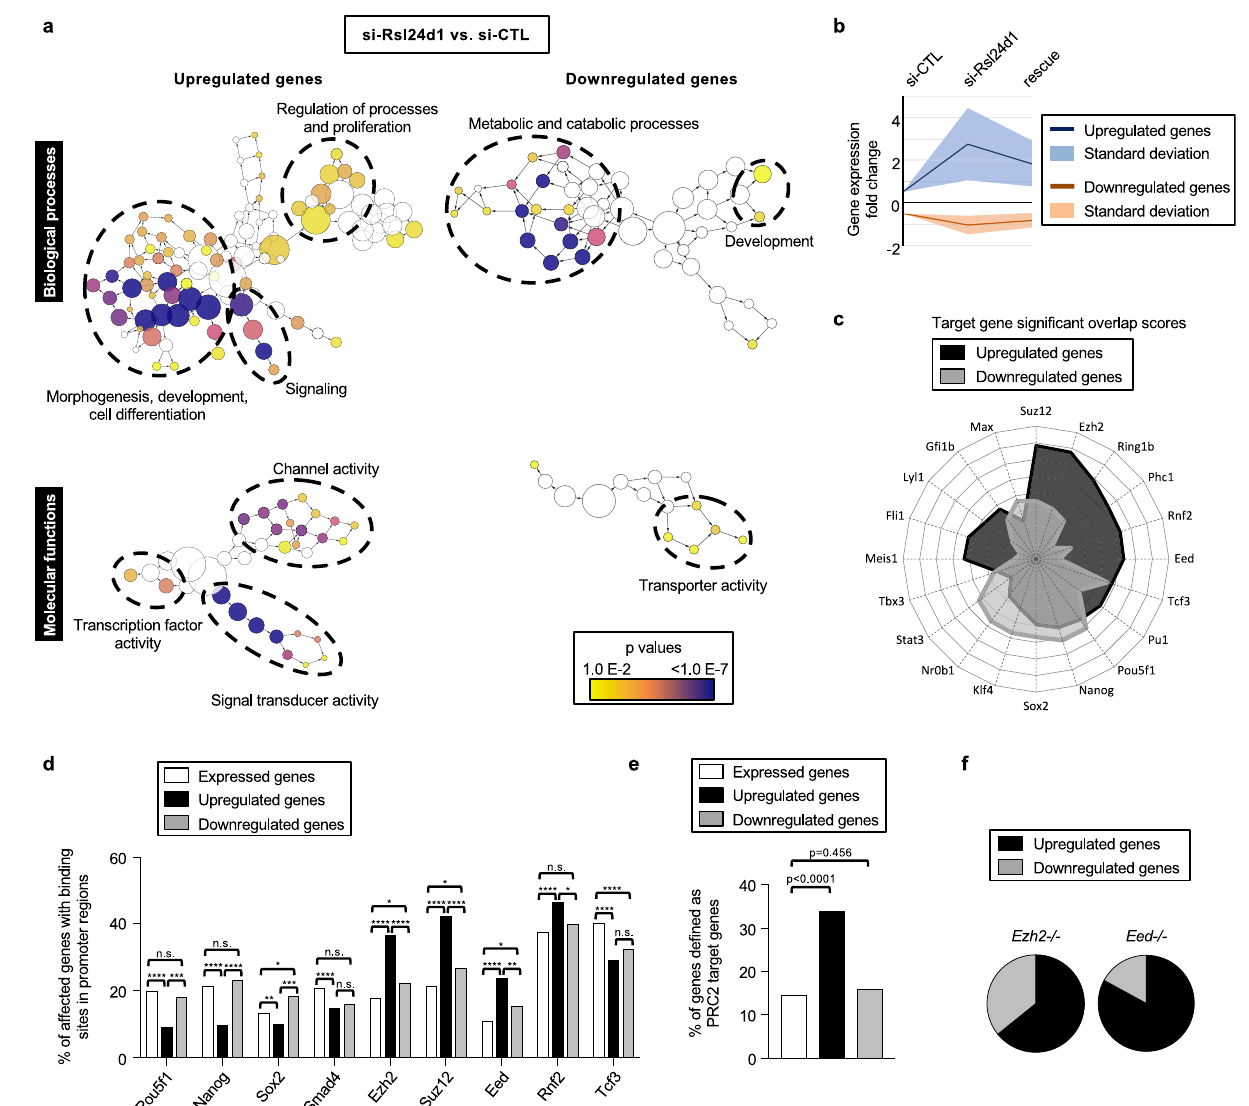
Fig. 4 | RSL24D1 is required to maintain the regulation of pluripotency and differentiation transcriptional programs. a Gene Ontology (GO) enrichment analysesofbiological process and molecularfunction terms associated with genes differentially expressed in CGR8 cells treated with Rsl24d1 siRNAs. The left and right panels represent hierarchical trees of the most enriched terms for genes up- or downregulated in Rsl24d1-depleted cells, respectively. The size of the nodes represents the numbers of genes associated to each GO term, and the corre- sponding p values are indicated by color codes. The most represented GO term categories are indicated. The corresponding data are available in Supplementary Data5A,B. b Graphshowingtheaveragefoldchangeforthe200mostdifferentially expressed genes between si-CTL, si-Rsl24d1 (si-Rsl24d1 no rescue) and rescue (si-Rsl24d1 with rescue) conditions. c Radar plot summarizing the StemChecker